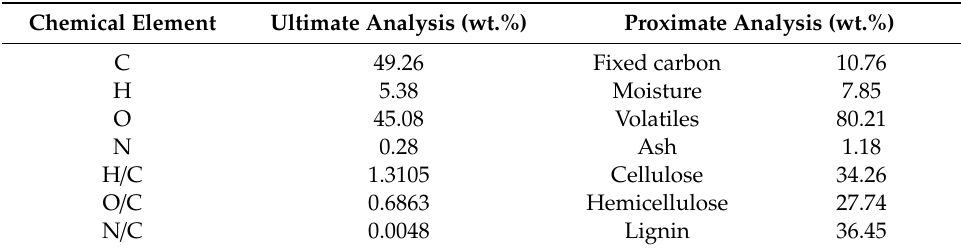
Table 1. Proximate ultimate analyses and of walnut